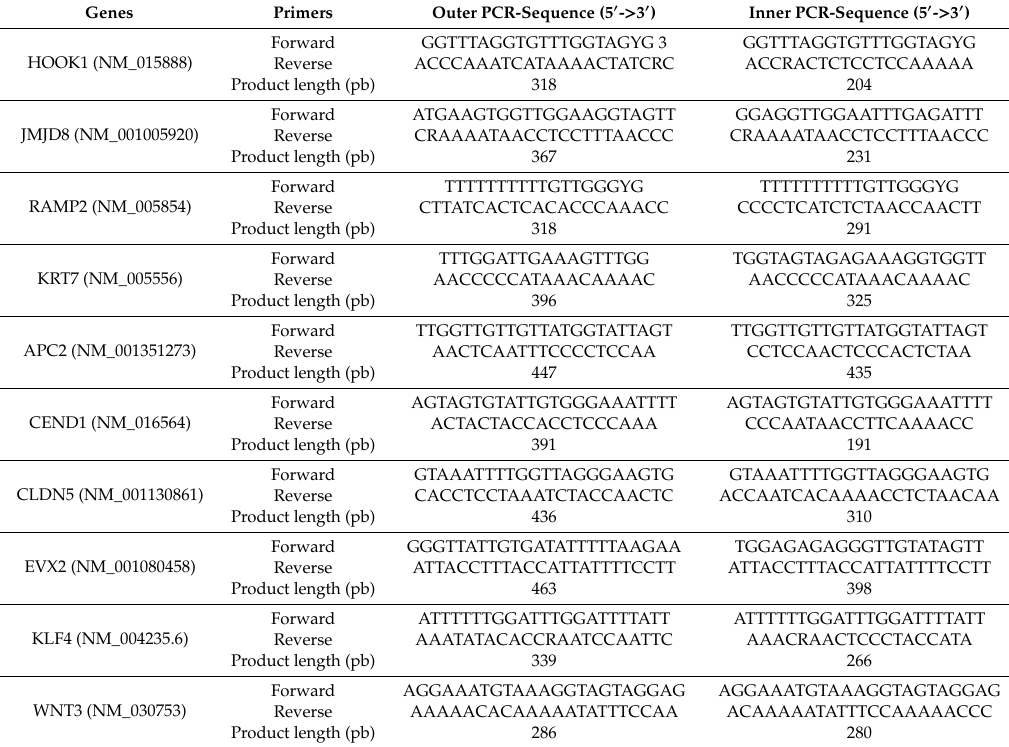
Table A3. Primers used for BSP